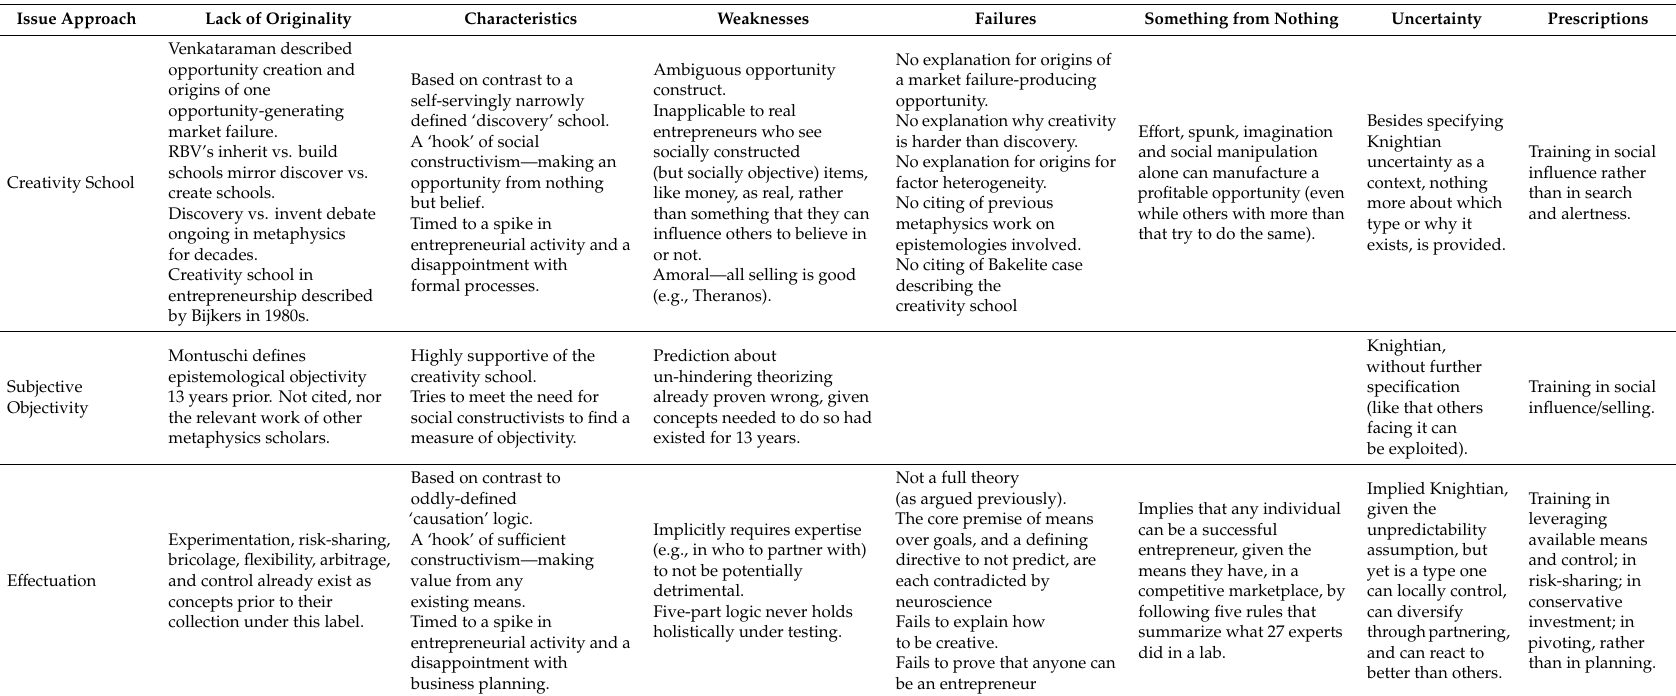
Table 1. Critical issues with dominant entrepreneurial decision-making